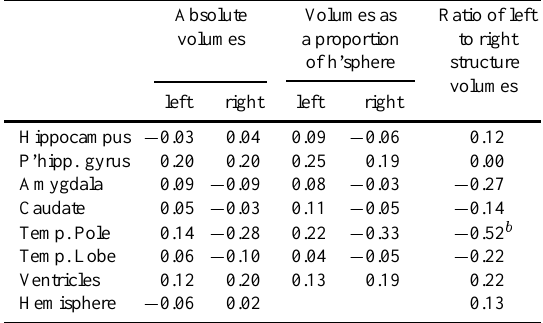
Table 6 Pearson’s product moment correlation coefficient for linear